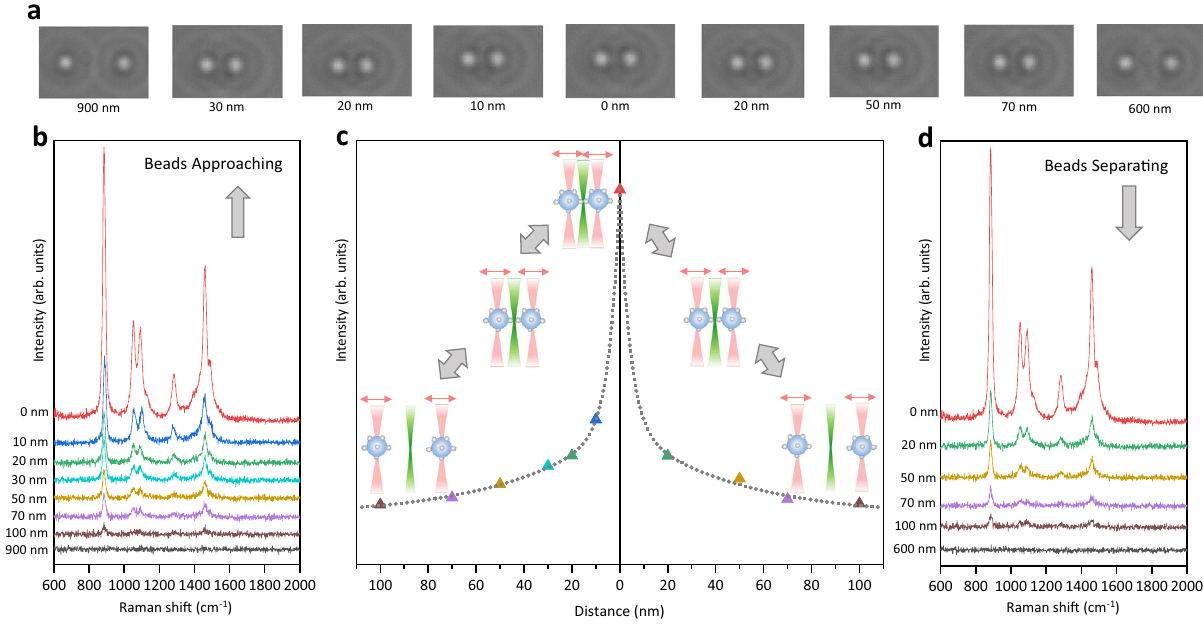
Fig. 2 Creation and adjustment of the dynamic hotspot with in situ SERS measurements of 1% ethanol aqueous solution. a The real-time camera images of the two AgNP-coated beads trapped at different distance. b SERS spectra of 1% ethanol aqueous solution with 1 s acquisition time when the two AgNP- coated beads approaching. c The intensity of the ethanol characteristic peak at 1458 cm − 1 as a function of the distance between the two AgNP-coated beads from beads approaching to beads separating. The reversible bead positions are illustrated as inset. d SERS spectra of 1% ethanol aqueous solution with 1 s acquisition time when the two AgNP-coated beads separating. Source data are provided as a Source data fi